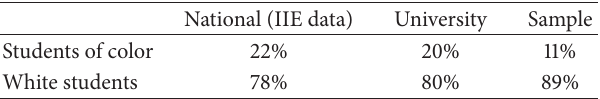
Table 1: Comparative demographic data: students who studied abroad, 2010-2011.